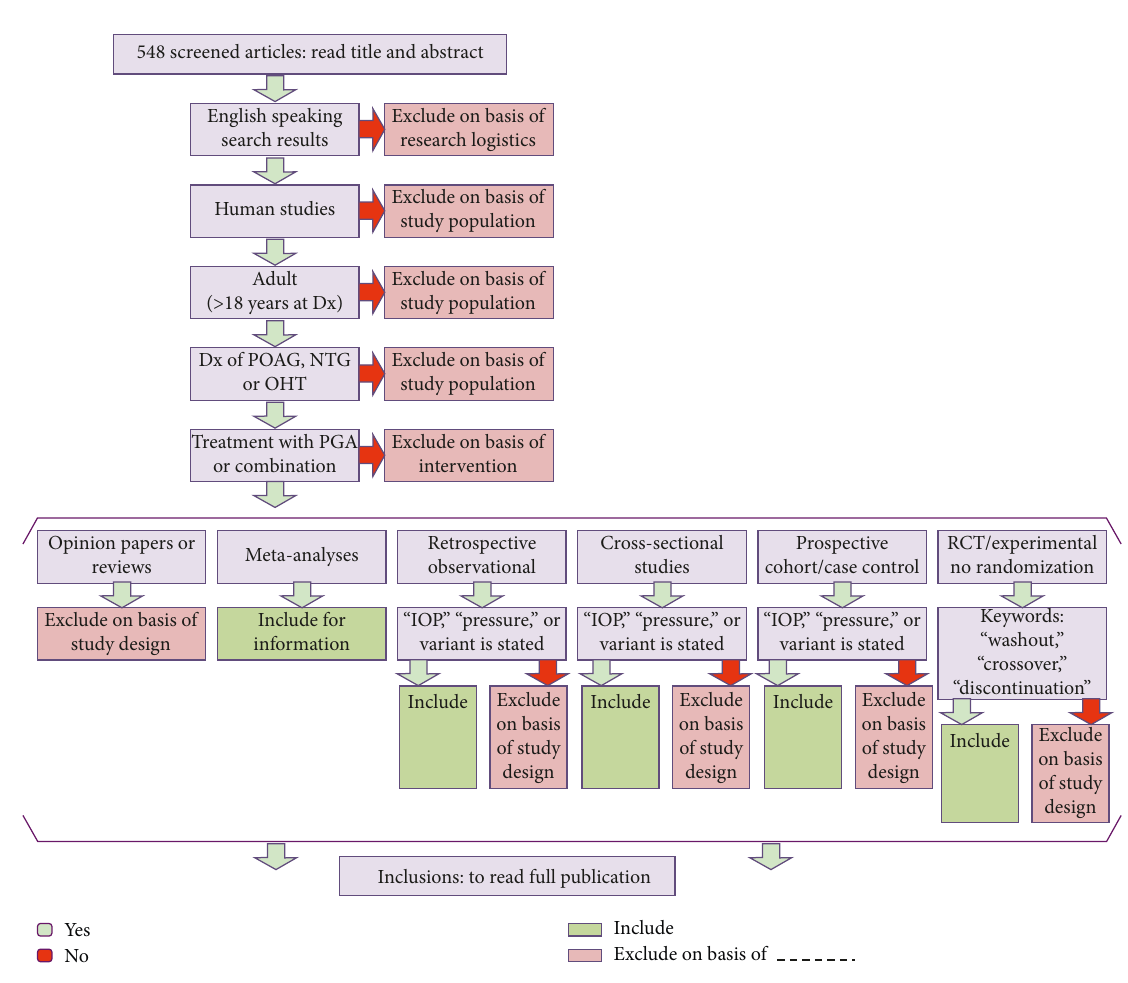
Figure 1: Inclusion and exclusion algorithm for screening